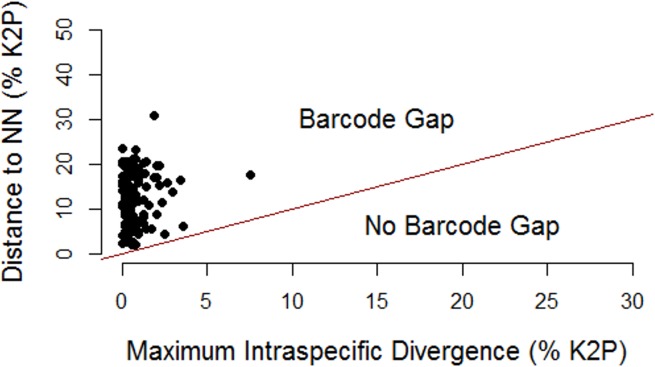
Barcode gap.Nearest-Neighbor distances (% K2P) plotted against maximum intraspecific divergences (% K2P) for 113 taxa with two or more individuals. All taxa show a barcode gap.